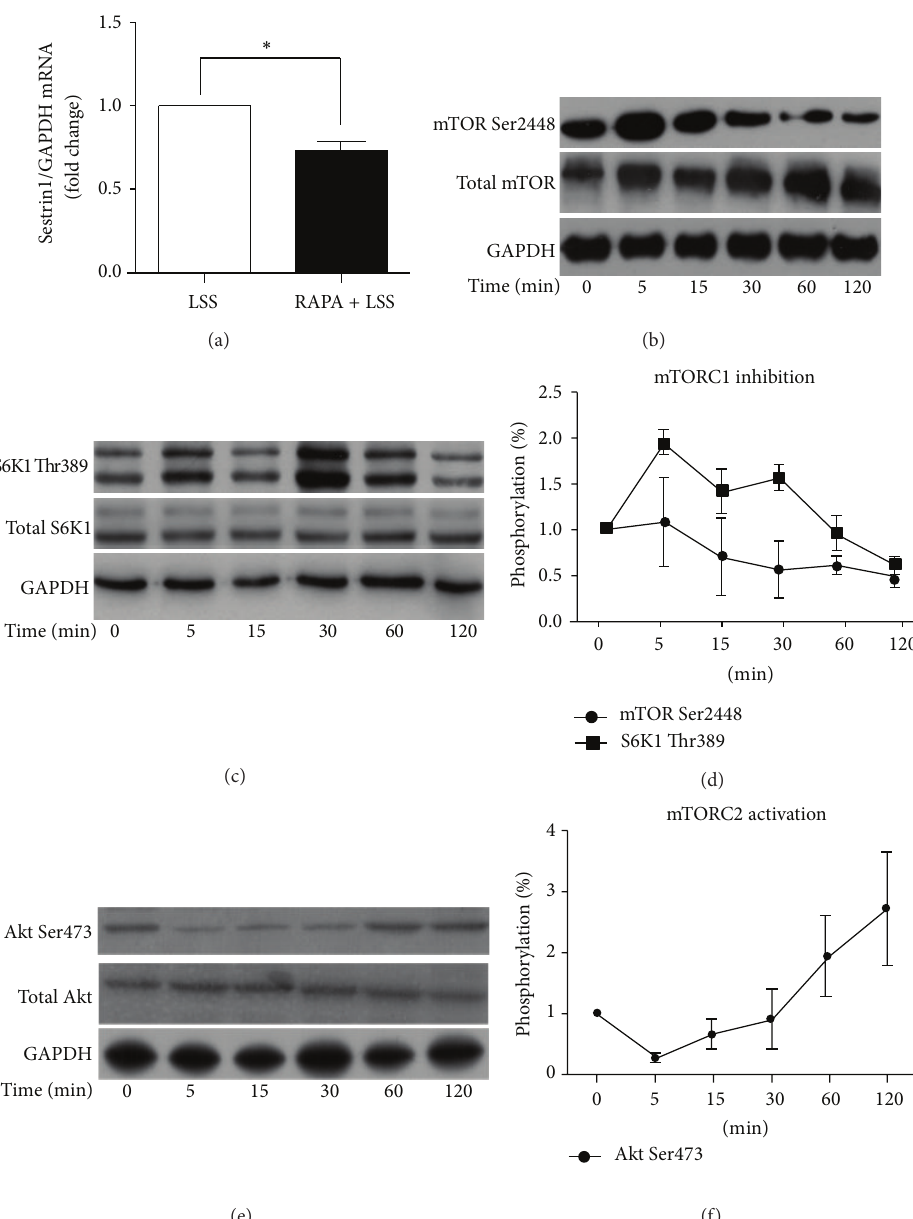
Figure 4: LSS reduced sestrin1 expression and caused contradictory activation of mTORC1 and mTORC2 in HUVECs. (a) Gene expression of sestrin1 normalized to the house-keeping gene gapdh was significantly decreased after shearing HUVECs at 2dyne/cm 2 for 120 min compared to static cells, ∗ 𝑃 < 0.05 ; 𝑛 = 4 . (b) Immunoblotting of mTORC1 activity at mTOR Ser2448 and S6K1 Thr389 phosphorylation sites (c). (d) The line graph below indicated the ratio of phosphorylated kinases to total proteins for each shearing time, with that of static cells set as 0 min. All data are from 3 independent experiments. (e) mTORC2 activity was determined by immunoblotting of Akt Ser473 phosphorylation with densimetric analysis of 3 independent experiments